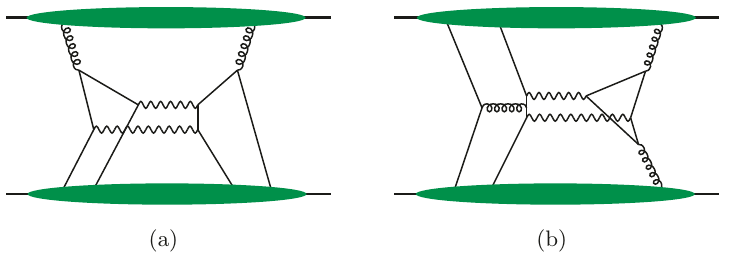
Figure 3 . (a) A graph with a twist-four distribution for one proton and a twist-two distribution for the other. (b) A graph with twist-three distributions for both